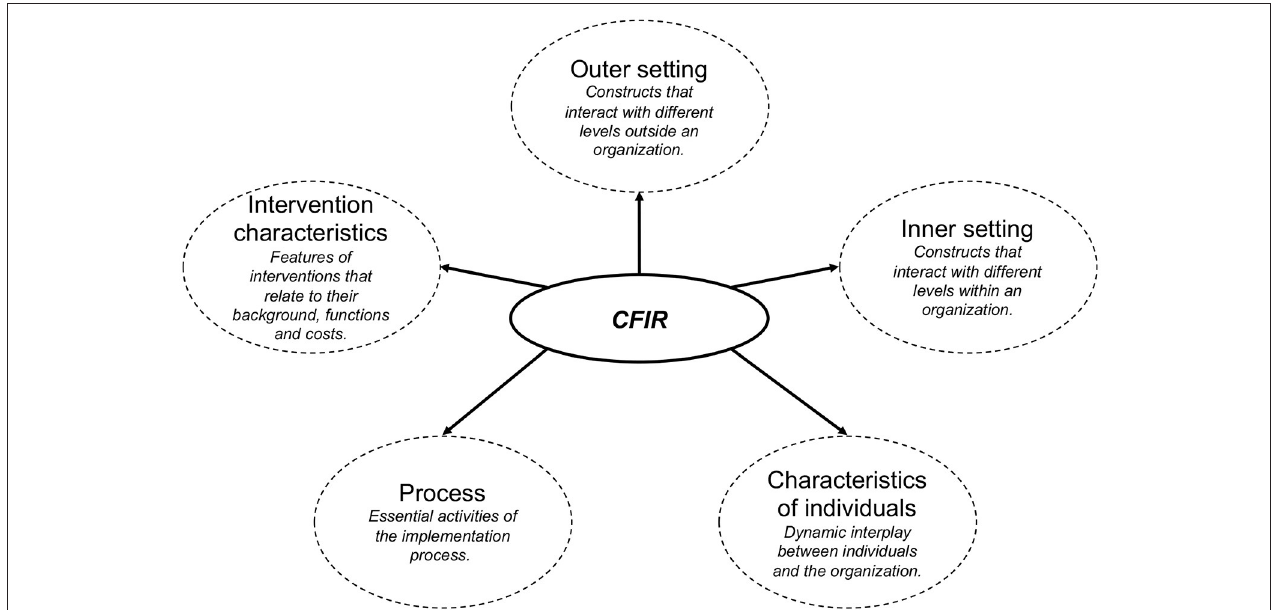
FIGURE 1 | Five domains of the original CFIR with a short description for each